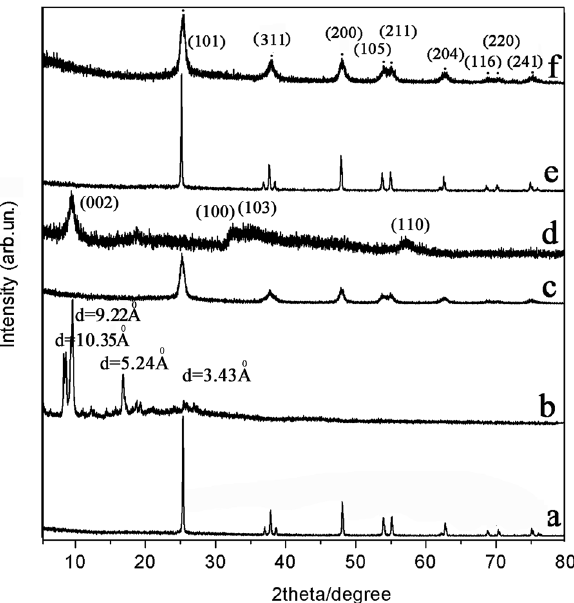
Figure 3. XRD patterns of TiO 2 ( a ), NH 2 -PDI ( b ), NH 2 -PDI/TiO 2 ( c ), MoS 2 ( d ), MoS 2 /TiO 2 ( e ), NH 2 -PDI/ TiO 2 /MoS 2 ( f ).